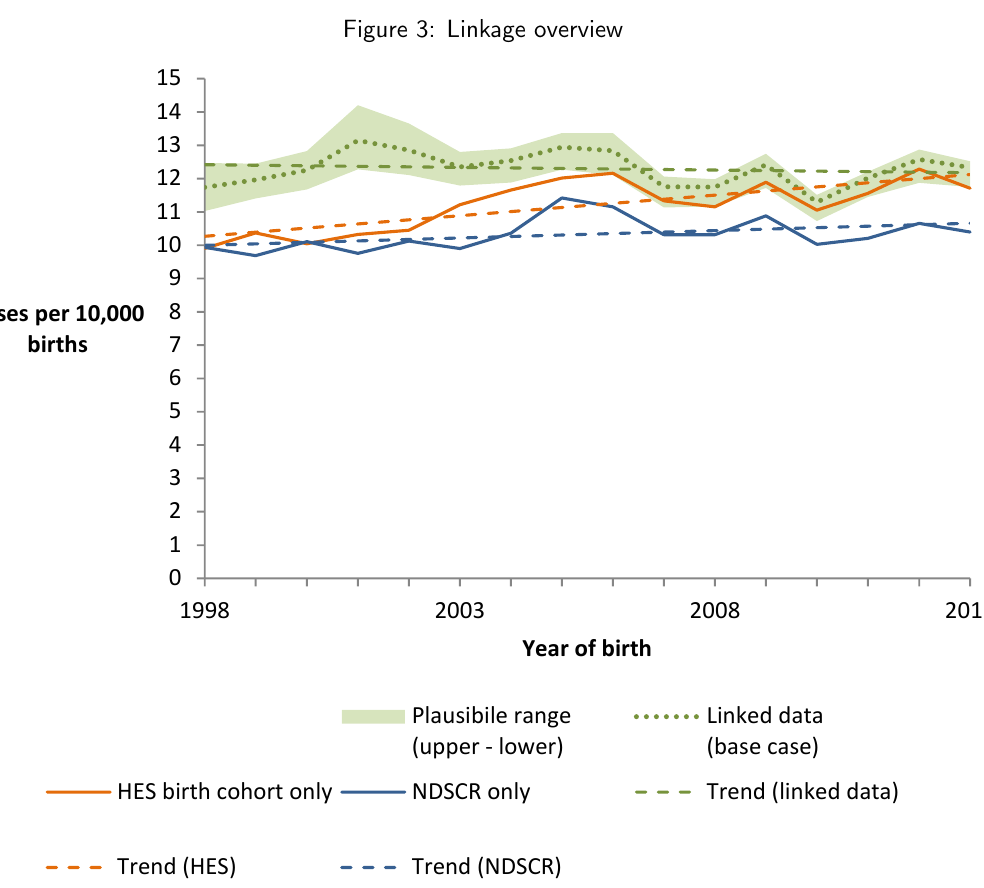
Figure 3: Linkage